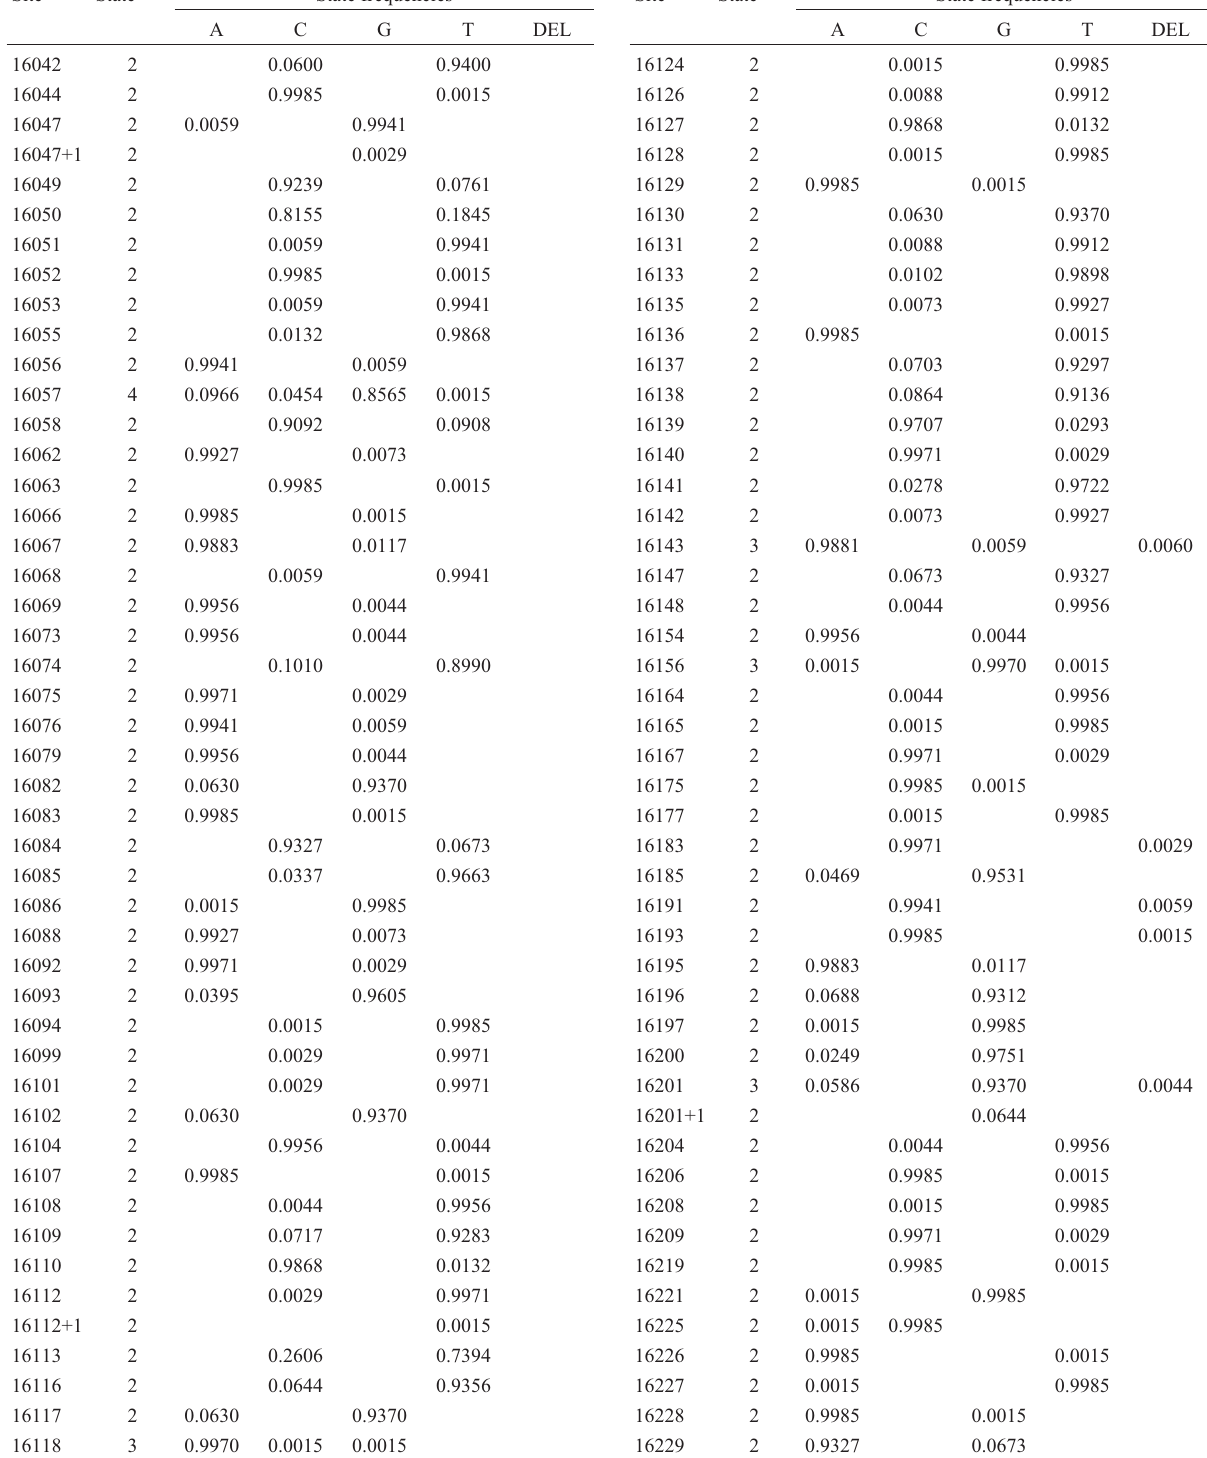
Table 3 - Polymorphic sites and nucleotide frequencies in a 210 bp D-loop fragment from 664 individuals of 54 different cattle